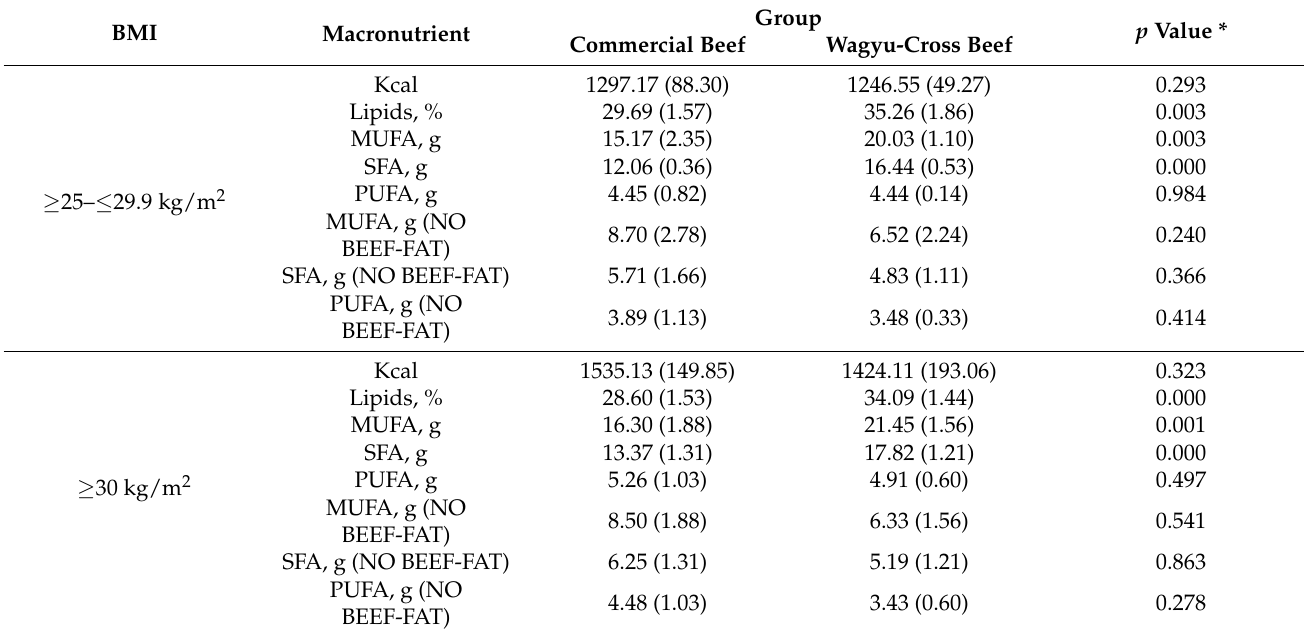
Table 2. Volunteers’ intake of fat and FA composition during the intervention 1